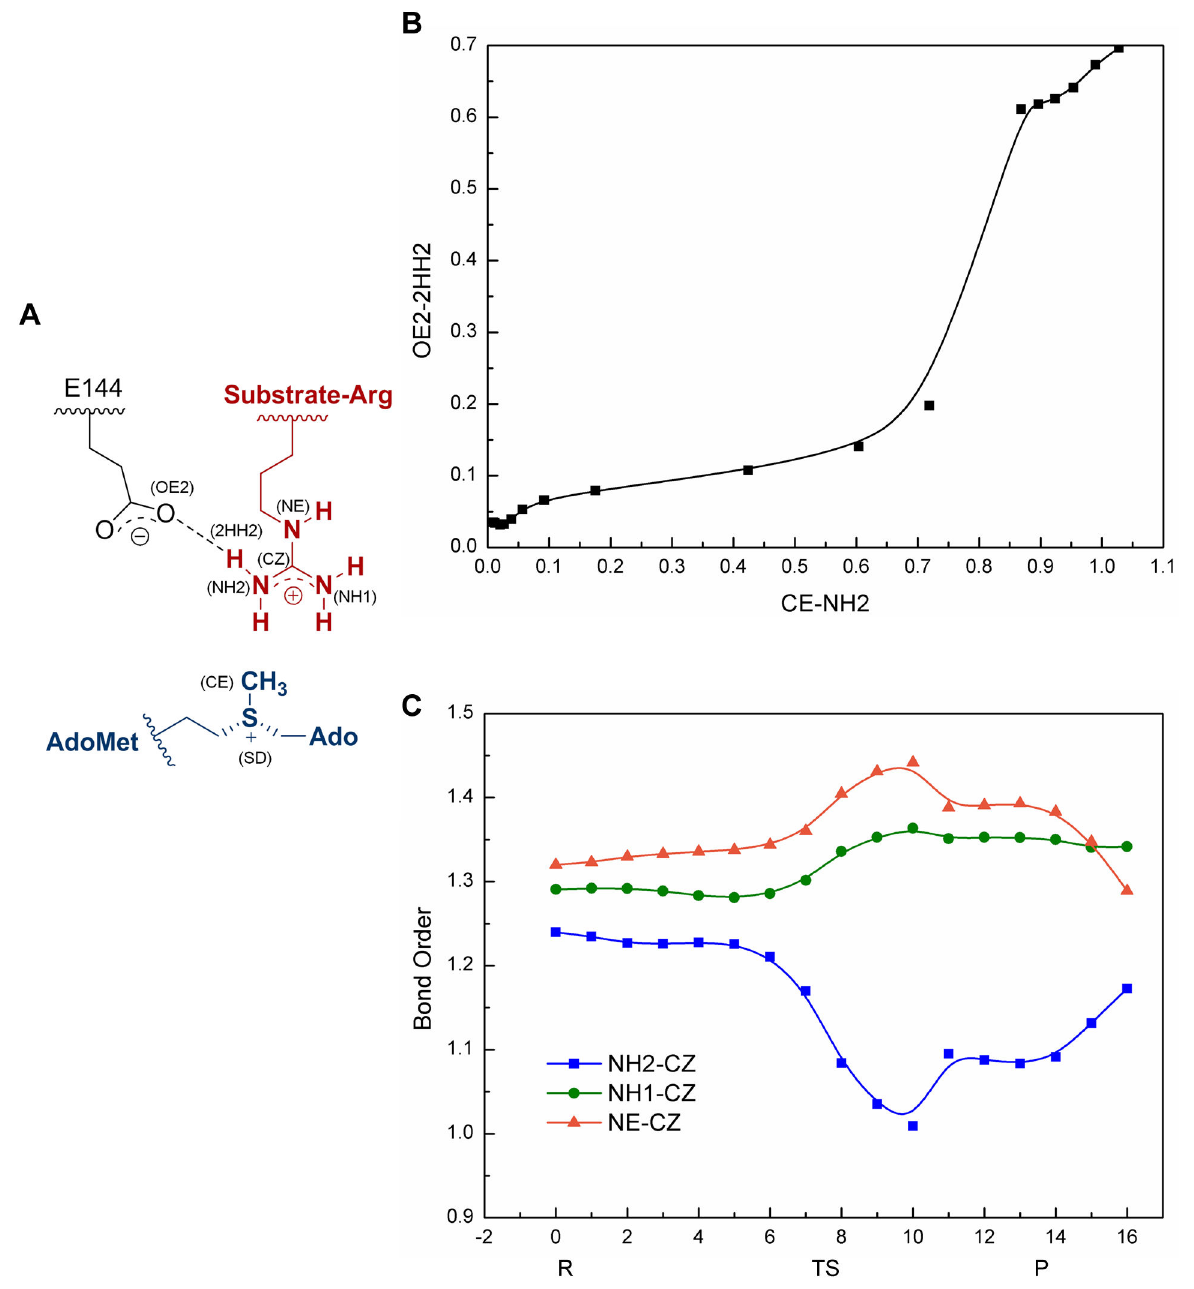
Figure 3. Evolution of the Wiberg bond order during the first methyl transfer. (A) Illustration of the bond and atom name. (B) The relationship between the formation of OE2-2HH2 and CE-NH2 suggests that deprotonation occurs after methyl transfer. (C) The bond order evolution involved in the guanidino group indicates the charge redistribution during reaction (R: Reactant, TS: S transition state, P: